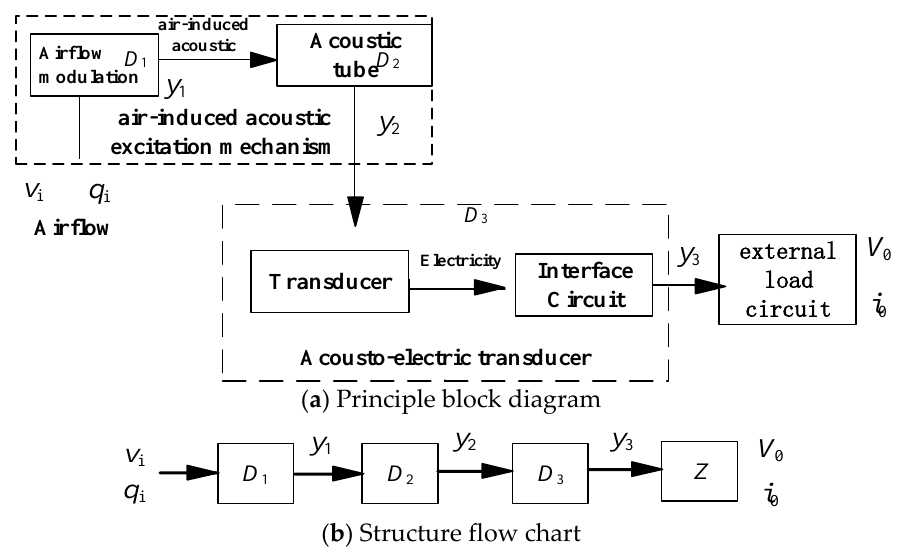
Figure 1. Working principle of the airflow-induced acoustic piezoelectric generator.